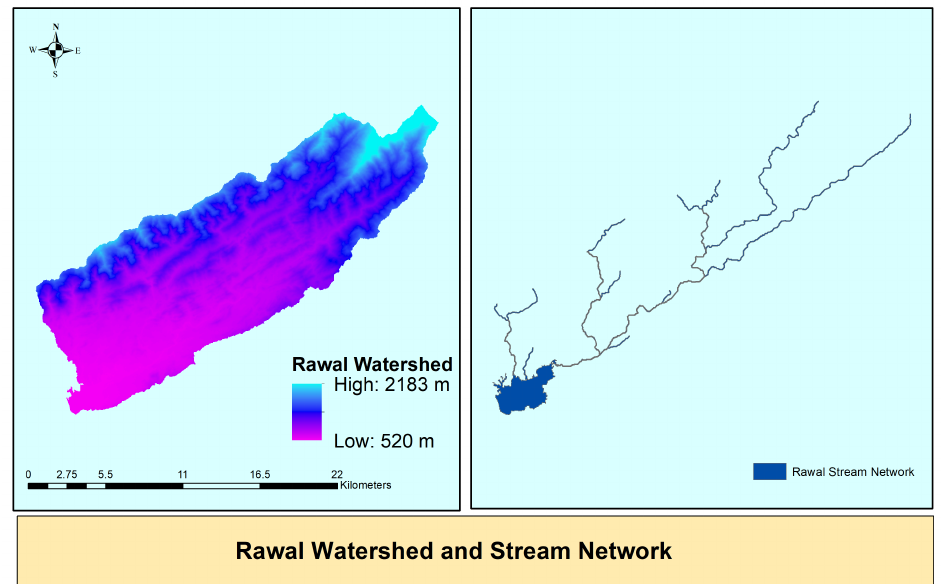
Figure 2. Study area DEM of the Rawal watershed and the stream network extracted after